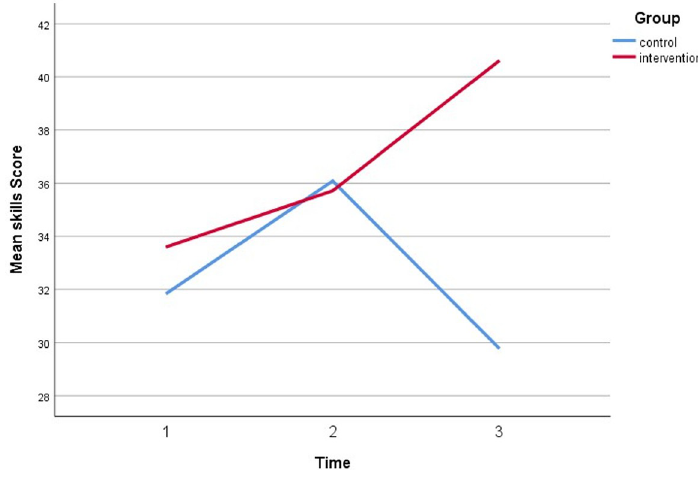
Fig 3. A plot of skills scores among respondents, showing an interaction between groups and time.